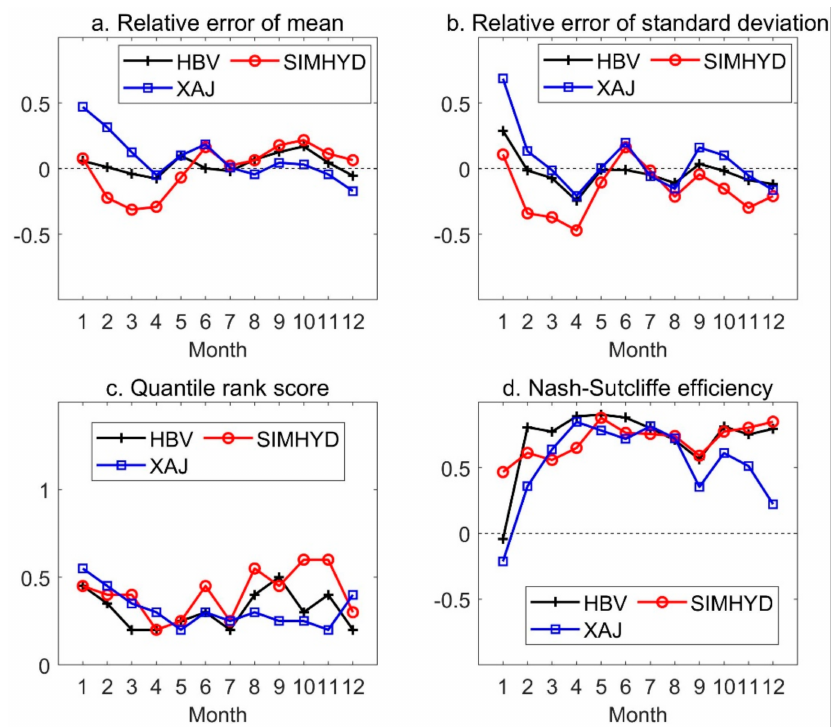
Figure 3. Performance of hydrological models by month in the baseline period driven by observed climate